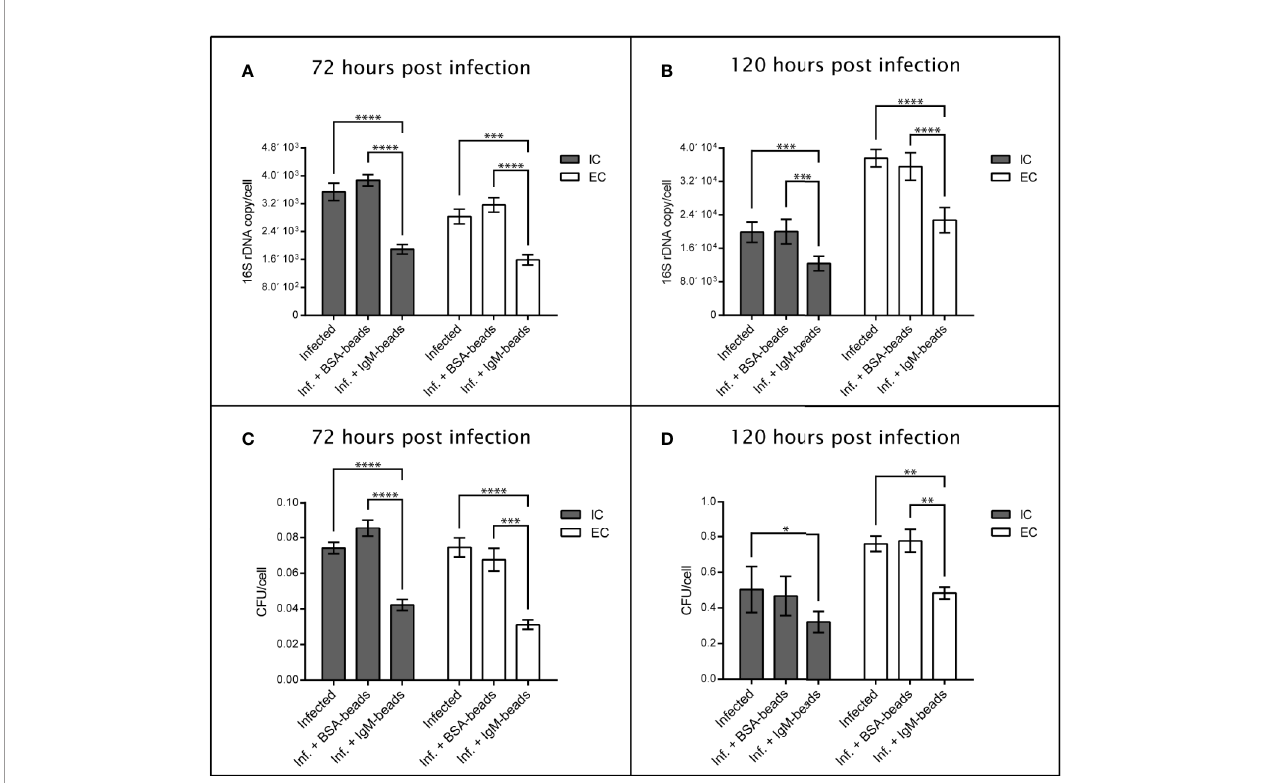
FIGURE 6 | Quanti fi cation of extracellular and intracellular P. salmonis recovered from SHK-1 infected cells treated with IgM-beads. SHK-1 cells were infected with P. salmonis at a MOI of 10 bacteria/cell and treated with IgM-beads. SHK-1 cells incubated with BSA-beads were used as controls for each time point. The bacterial load was determined by quanti fi cation of 16S rDNA copy/cell at 72 hpi (A) and 120 hpi (B) , and also by quanti fi cation of CFU/cell at 72 hpi (C) and 120 hpi (D) . The statistical analysis was performed through a parametric ANOVA with a Tukey multiple comparison test. Signi fi cant differences: *p < 0.05, **p < 0.01, ***p < 0.001, ****p <